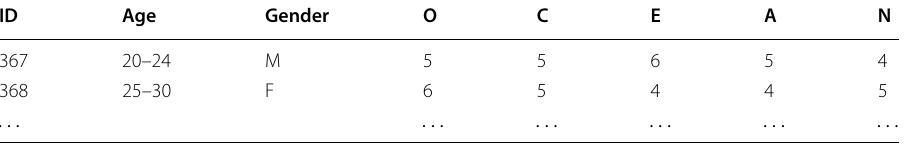
Table 2 Example of data from ITM-Rec ID Age